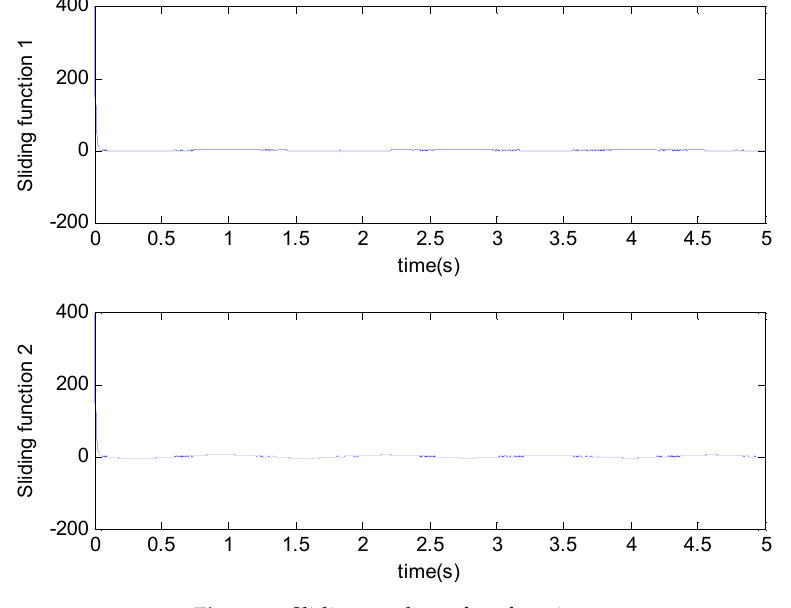
Figure 6. Sliding mode surface function.